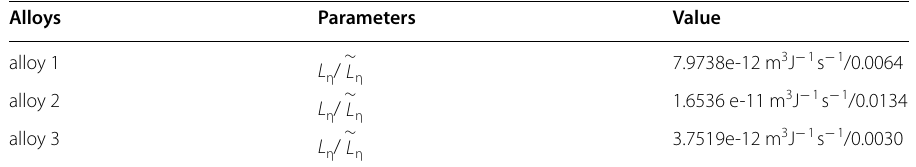
Table 2 Parameters for 2D simulations (100 nm